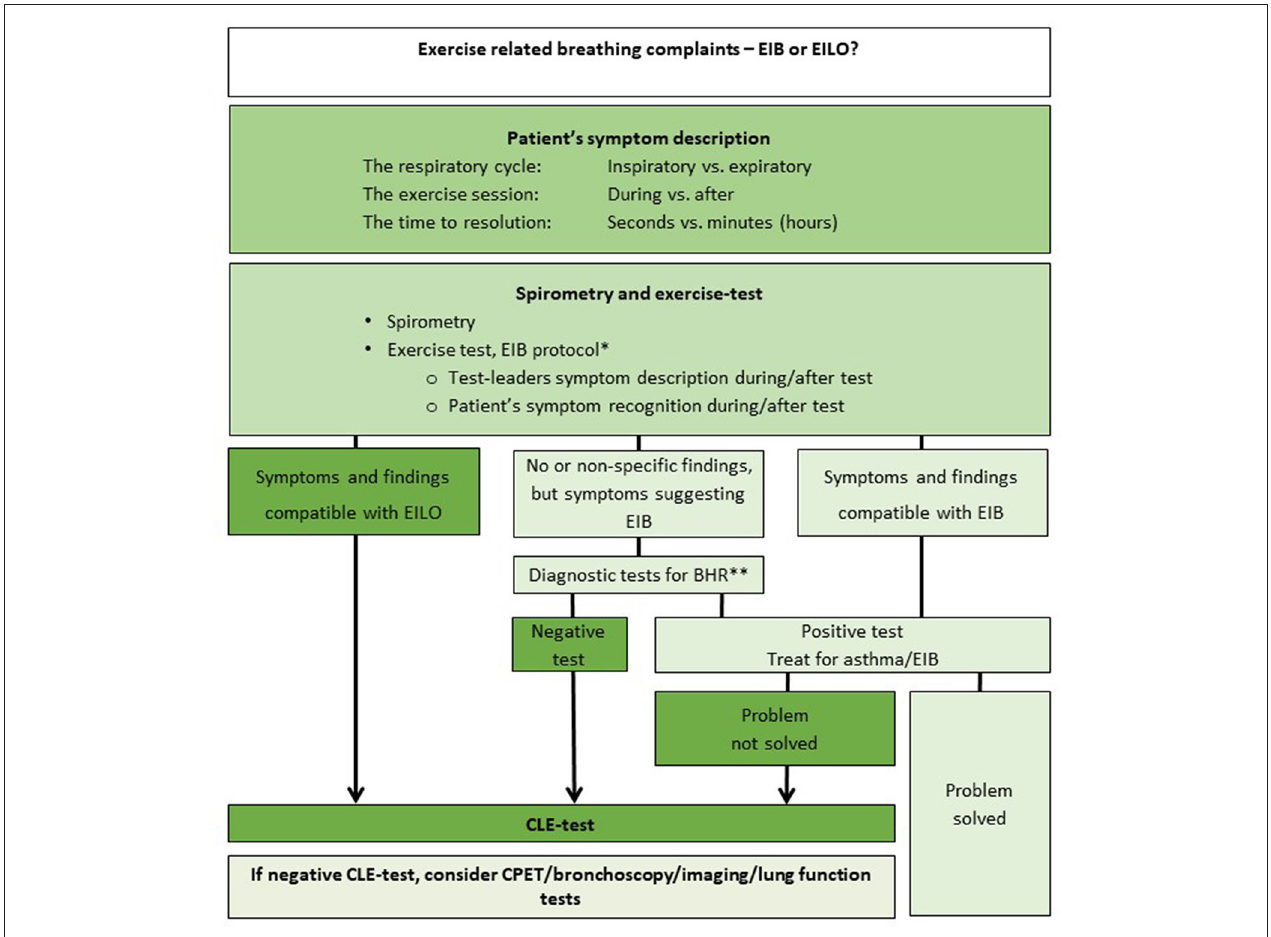
FIGURE 2 | Symptom presentation in the patient with exercise induced breathing complaints, differences between EIB and EILO. EIB, exercise induced bronchoconstriction; EILO, exercise induced laryngeal obstruction. Modified from Paediatric Respiratory reviews ( 47).